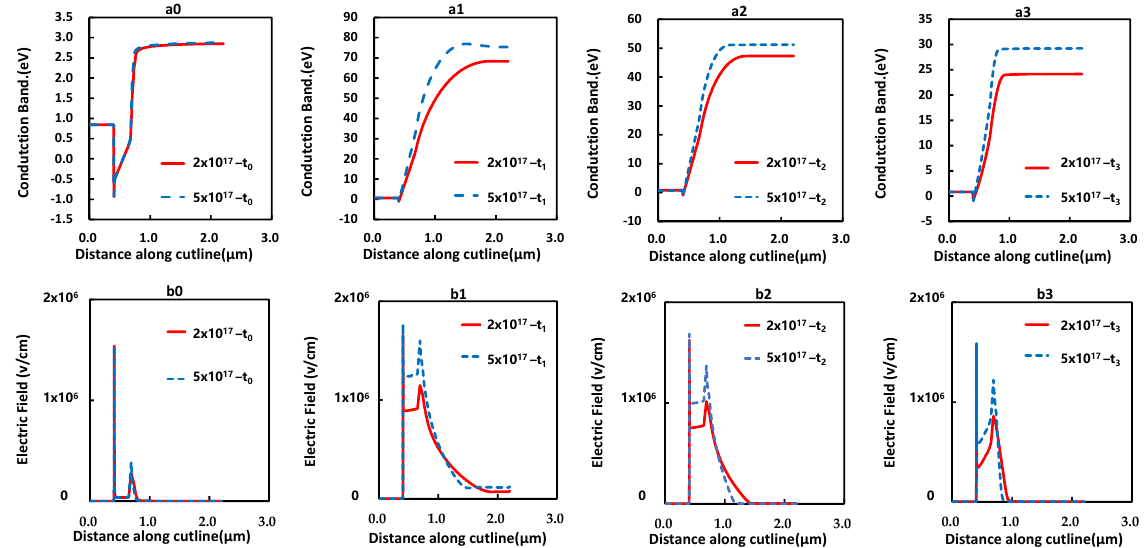
Figure 11. The transient current for the C-doping concentration at 2 × 10 17 cm − 3 and 5 × 10 17 cm − 3 in the buffer after stress.